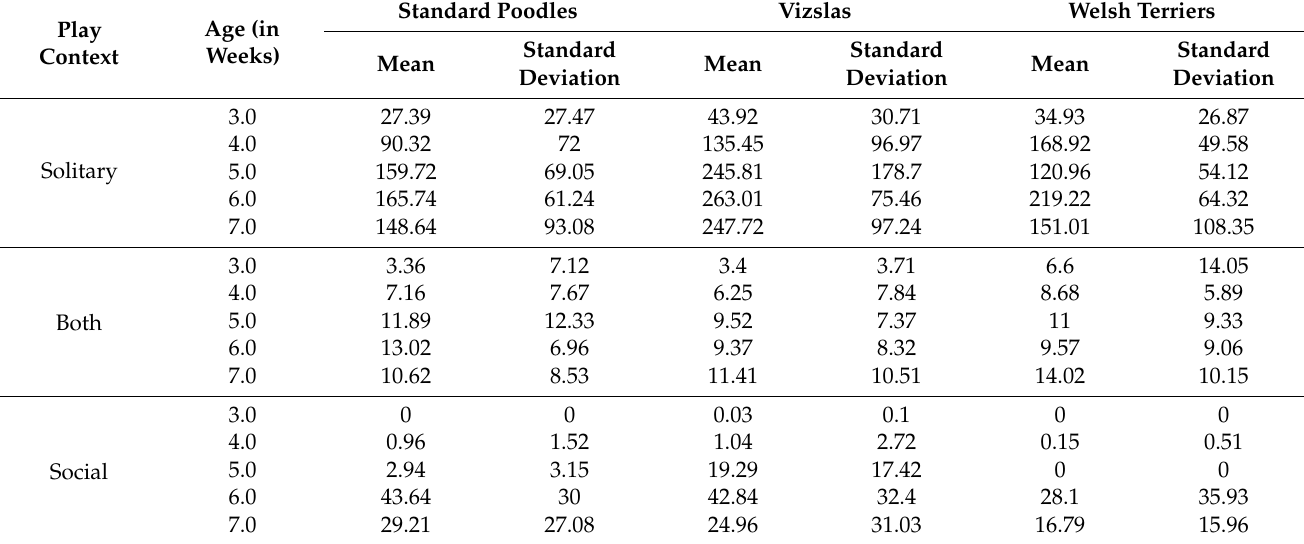
Table 5. Play Context Means. Means and standard deviations for play context: solitary only (SOL); social only (SOC); and behaviors that occur in both contexts (B) for each breed (standard Poodles, Vizslas, and Welsh Terriers) from 3–7